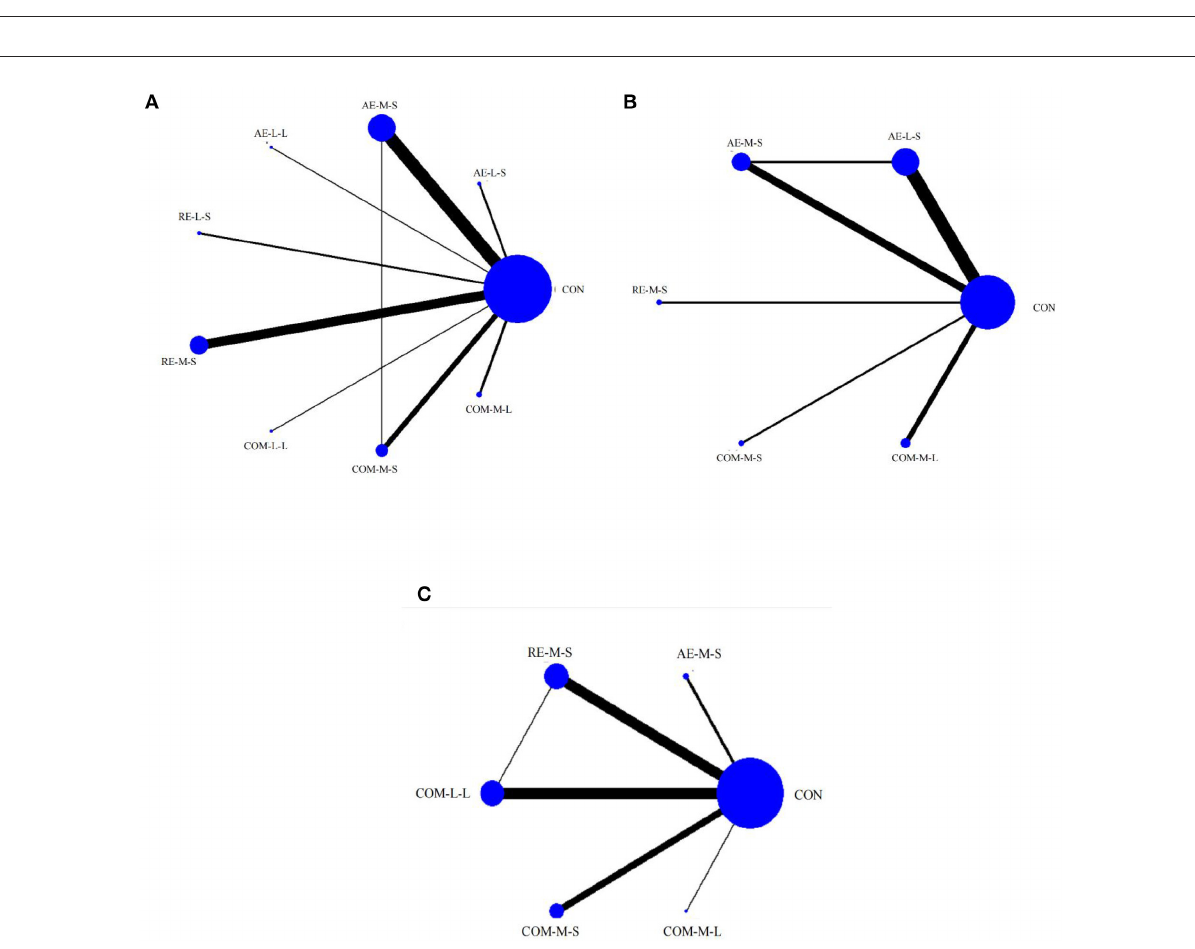
FIGURE3 Network meta-analysis maps of the studies examining the efficacy of exercise interventions on (A) FIQ, (B) TPC, (C) 6WMT.